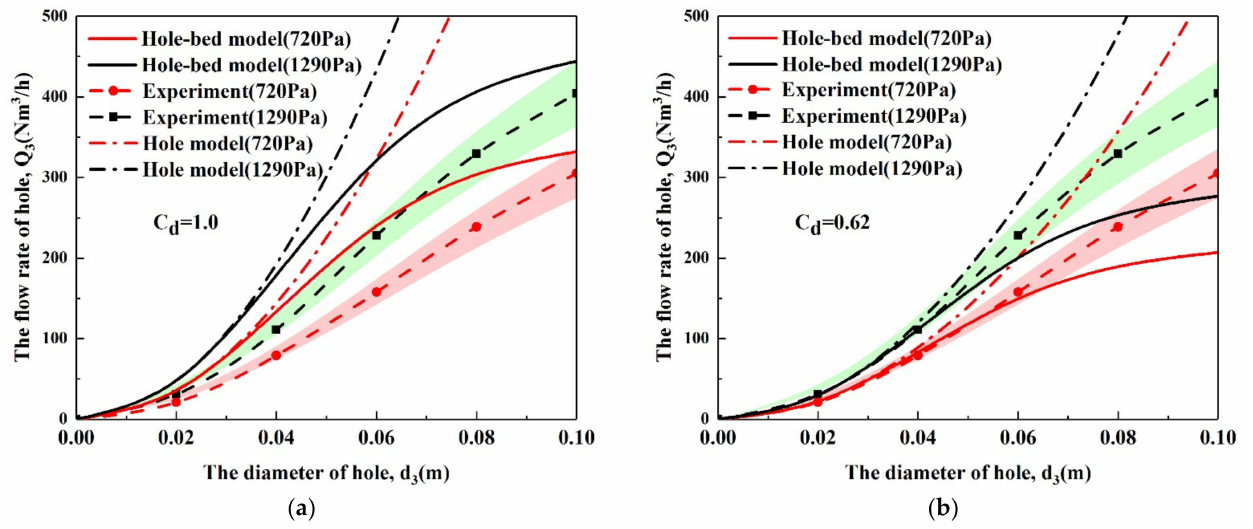
Figure 10. The model validations of the hole–bed model in the laboratory. ( a ) Case: the flow coefficient C d = 1; ( b ) Case: the flow coefficient C d =